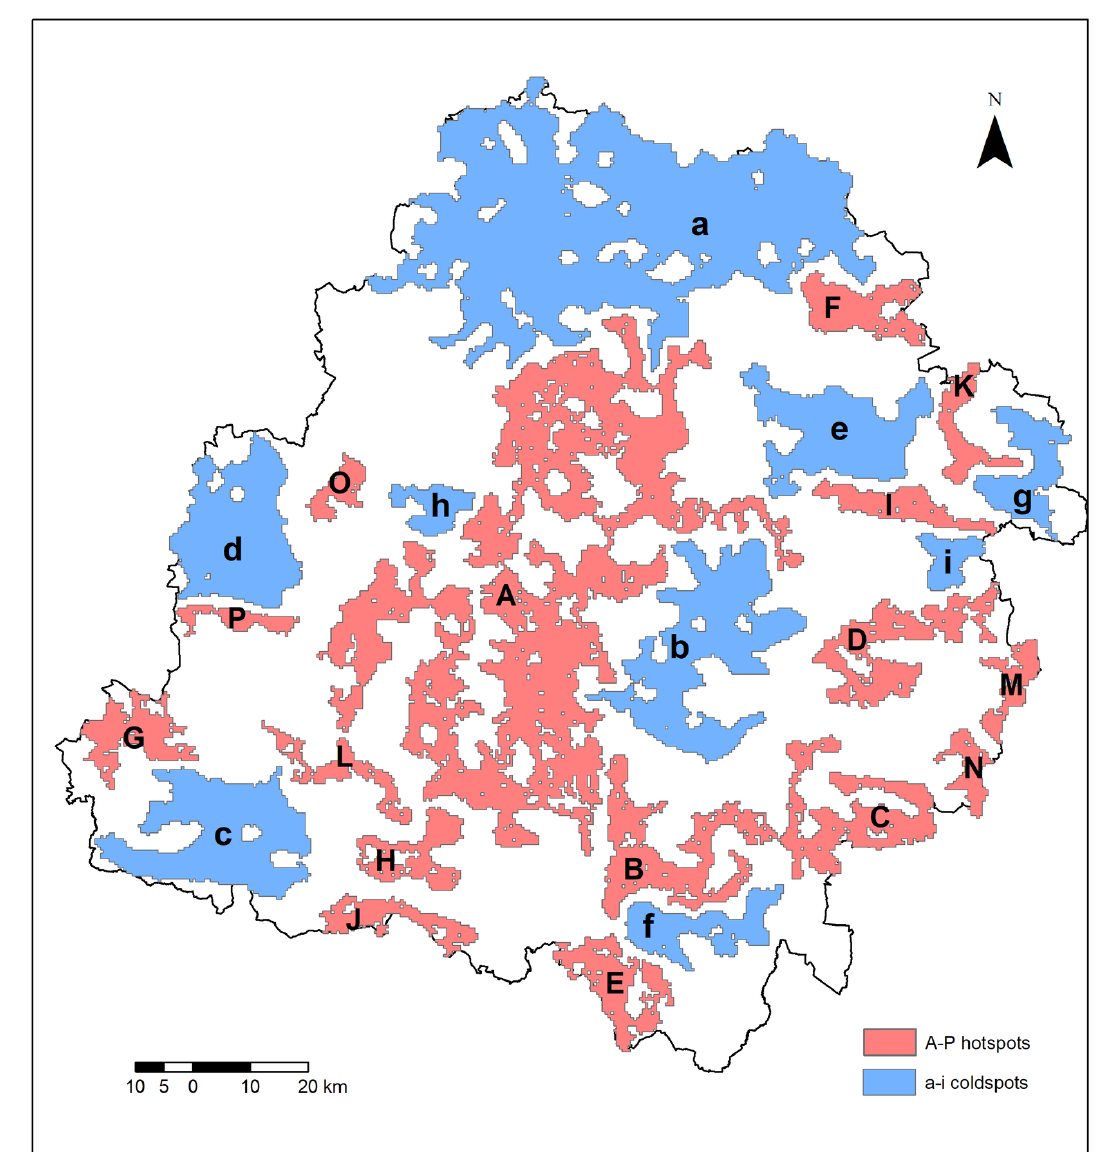
Figure 8. Heatmap with cold- and hotspots of a surface area greater than 50 km 2